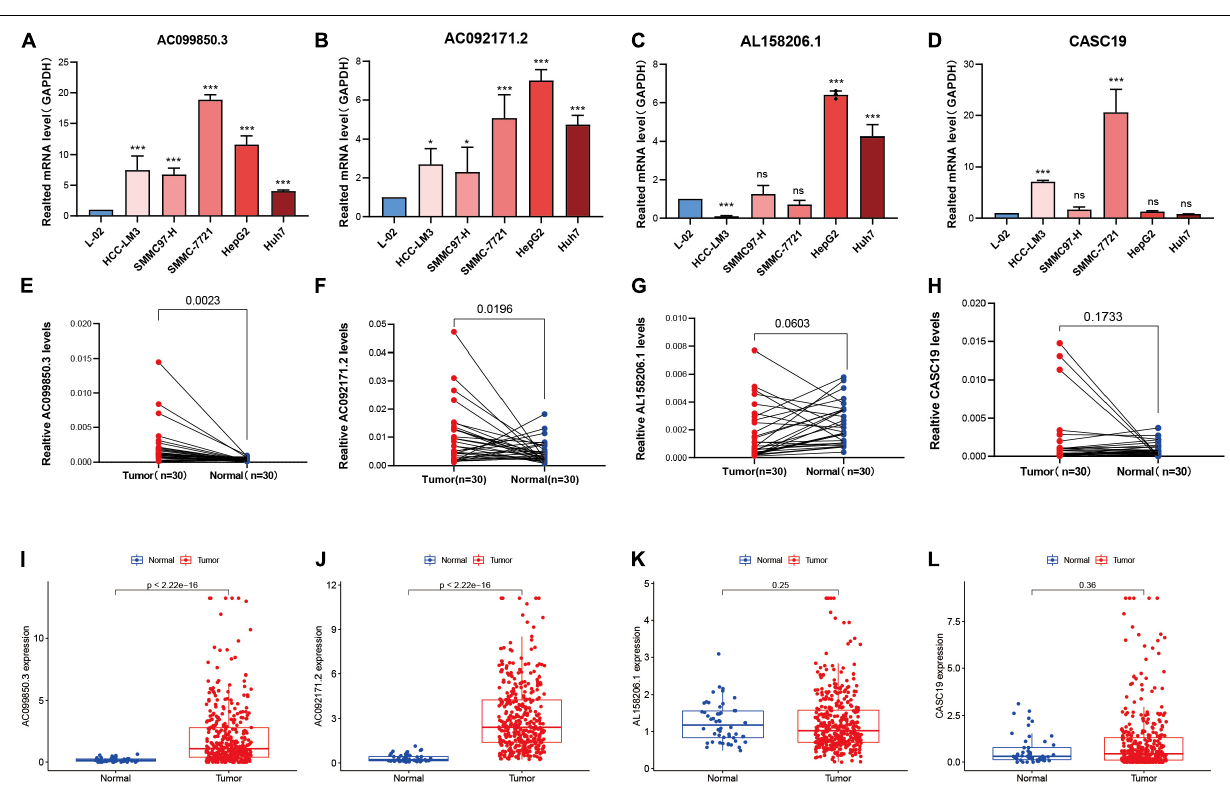
FIGURE 5 | Expression level of lncRNAs in HCC cell lines, clinical tissue samples, and TCGA database. (A–D) The RT-qPCR analysis of the expression levels of AC099850.3, AC092171.2, AL158206.1, and CASC19 in five HCC cells and normal liver cell line (L-02). Error bars represent the SD of triplicate experiments. (E–H) The expression levels of AC099850.3, AC092171.2, AL158206.1, and CASC19 in 30 paired carcinoma tissues and adjacent tissues in HCC patients. (I–L) Expression analysis of AC099850.3, AC092171.2, AL158206.1, and CASC19 in HCC tissues and normal tissues derived from TCGA dataset. ns: not statistically significant, * p < 0.05 and *** p <